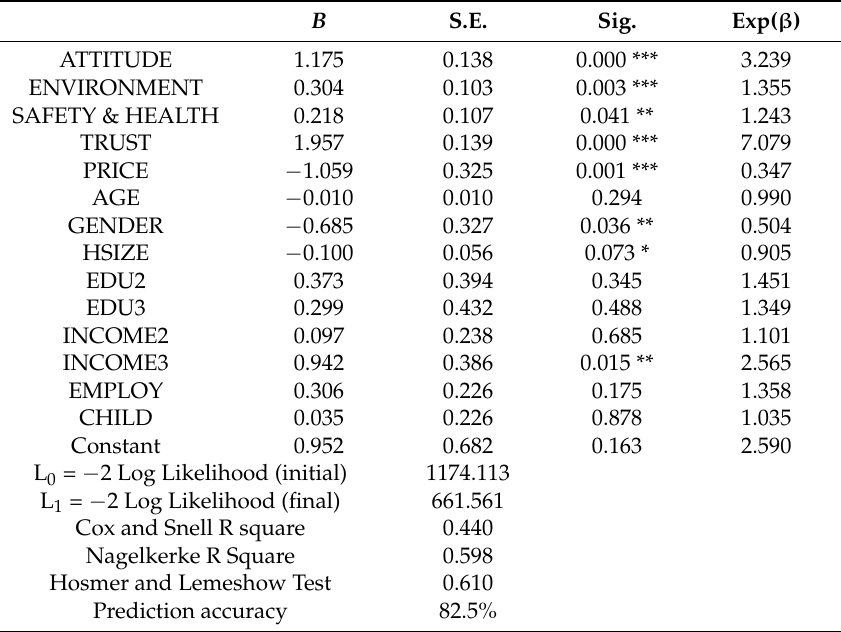
Table 4. Estimated logit model for consumers’ organic vegetable purchasing.